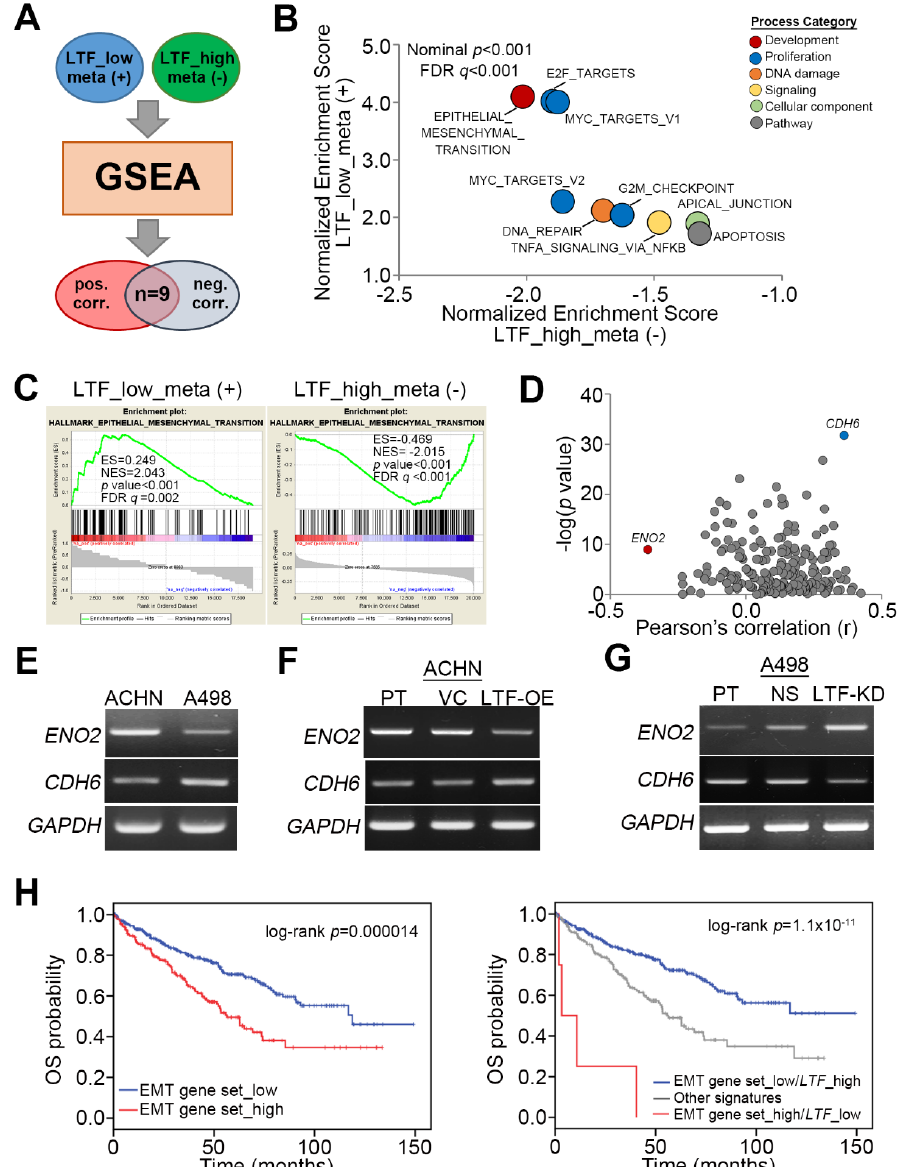
Figure 4. LTF expression inversely correlates with the progression of epithelial-mesenchymal transition in ccRCC. ( A , B ) Flowchart ( A ) and results ( B ) of GSEA analysis against Pearson’s correlation test for LTF co-expression with somatic genes in metastatic ccRCC with low LTF expression and nonmetastatic ccRCC with high LTF expression using TCGA ccRCC database. ( C ) The enrichment score (ES) derived from the correlation between the epithelial-mesenchymal transition gene set and the queried Pearson’s correlation coe ffi cient (r) is plotted (green curve). NES and FDR denote the normalized enrichment score and false discovery rate, respectively. ( D ) Scatchard plots for Pearson’s correlation coe ffi cient and the –log [ p value] derived from Pearson’s correlation test for the mRNA levels between POLQ and the genes in the epithelial-mesenchymal transition gene set in metastatic ccRCC with low LTF expression. ( E – G ) RT-PCR analyses of ENO2, CDH6 and GAPDH gene expression in ACHN and A498 cells ( E ); ACHN cells without (PT) or with VC and LTF-OE ( F ); or A498 cells without (PT) or with NS and LTF-KD ( G ). GAPDH was used as an internal control for RT-PCR experiments. ( H ) Kaplan–Meier analyses of OS at a maximal risk condition for the mRNA levels of the epithelial-mesenchymal transition (EMT) gene set alone [left; low ( n = 343), high ( n = 177)] or combined with LTF gene expression [right; EMT gene set_low / LTF_high (n = 334), other signatures ( n = 182), EMT gene set _high / LTF_low ( n = 4)] in TCGA ccRCC